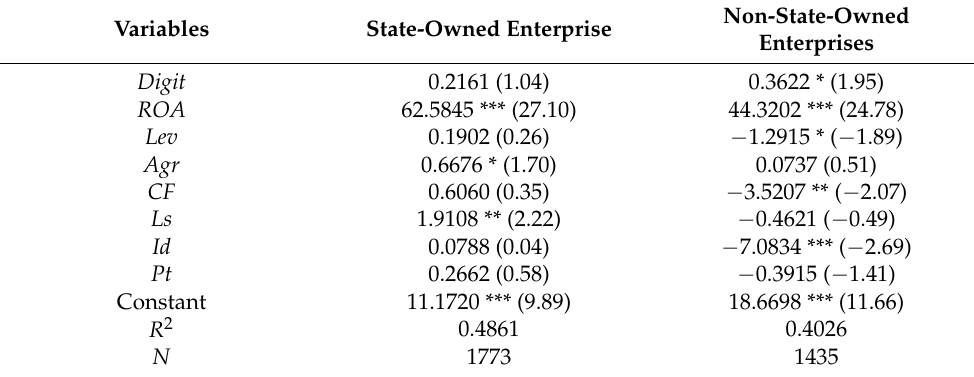
Table 11. Regression results of distinguishing property rights.